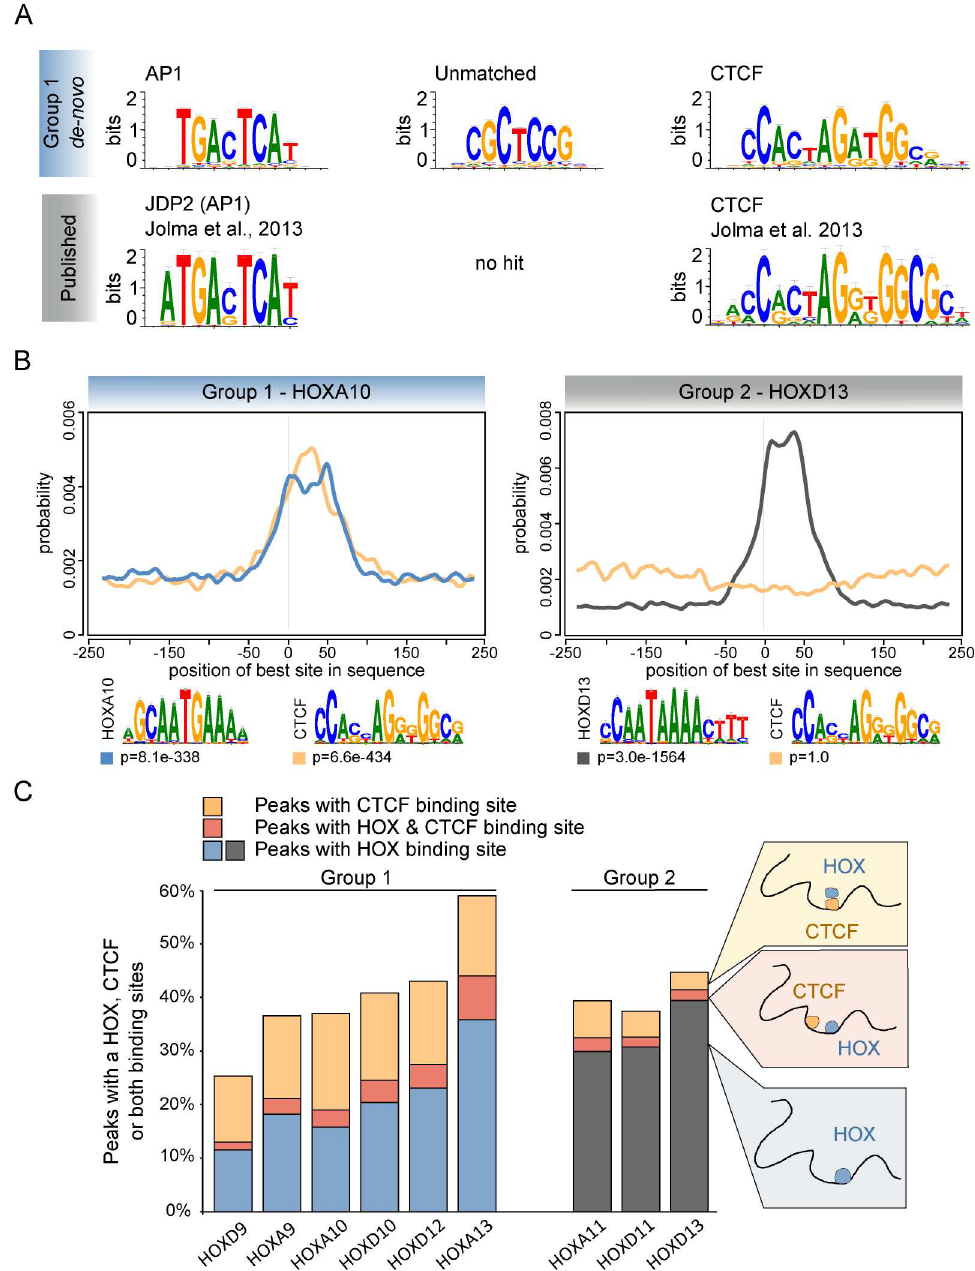
Fig 3. AP1 and CTCF binding sites are overrepresented in Group 1 HOX-TF binding sites. (A) De novo motif analysisof all Group 1 HOX-TF peaks (here, HOXA10 results) identifiesoverrepresented bindingsites. A comparisonof these motifs to knownAP1 and CTCF motifs is shown below. (B) Centrimo analysisidentifiesthe positionof best bindingsite matches in all peak sequences.Blue and black lines indicateenrichment of the given HOXA10 or HOXD13 motif shown below, respectively. Yellow lines indicateenrichment for CTCF motif shown below. (C) The overlap of peaks containinga HOX (Group 1- blue, Group 2- black) or a CTCF (yellow) binding site. The red overlap indicatespeaks containing a HOX and a CTCF